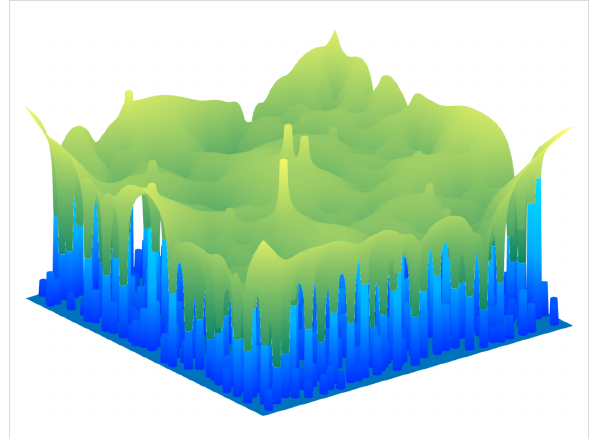
Figure 1: Simulated surface of a rough brush (blue) in adhesive con- tact with an elastic half-space (green). Along the boundary of the square, one can see the pillars, whose heights are statistically distri- buted. The elastic half-space is represented only by its surface. At the location of the highest pillars, one can see the “spikes”, which stem from pillars which are strongly pressed into the elastic half-space. At lower pillar heights (see the side of the contact) one can see the “negative spikes” which stem from the not-yet-destroyed adhesive contacts of individual pillars loaded in